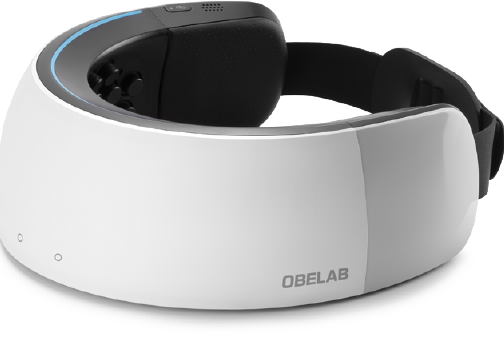
Figure 1. Obelab NIRSIT